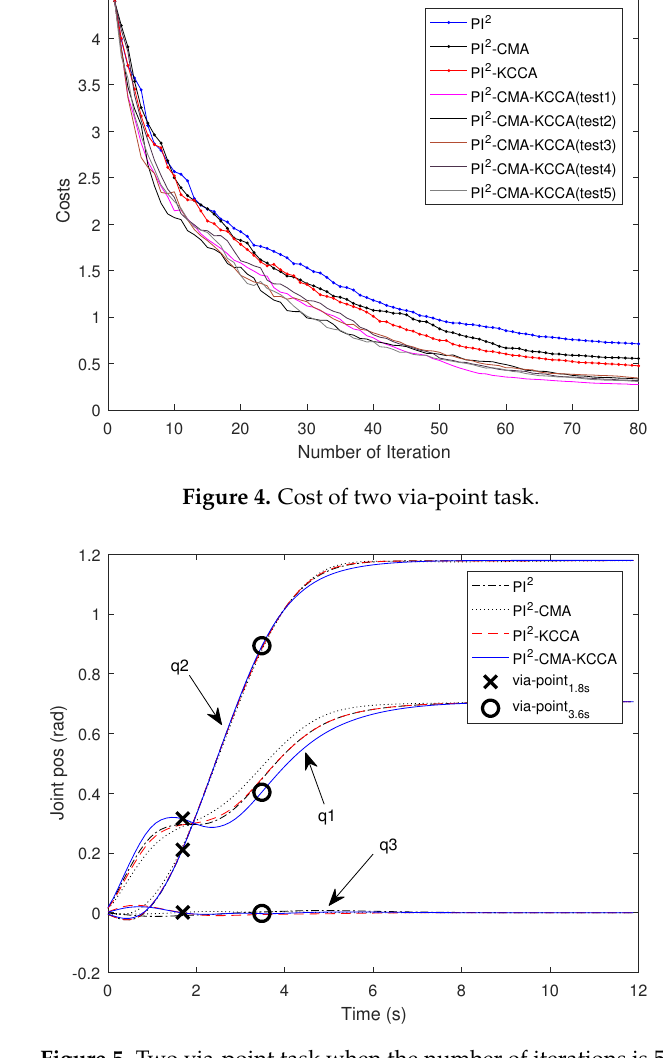
Figure 5. Two via-point task when the number of iterations is